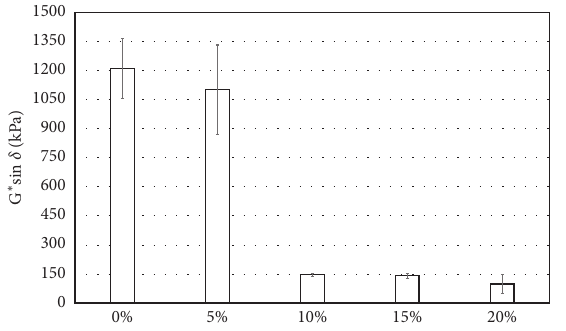
Figure 9: G ∗ sin δ of SIS binders at 25 ° C.